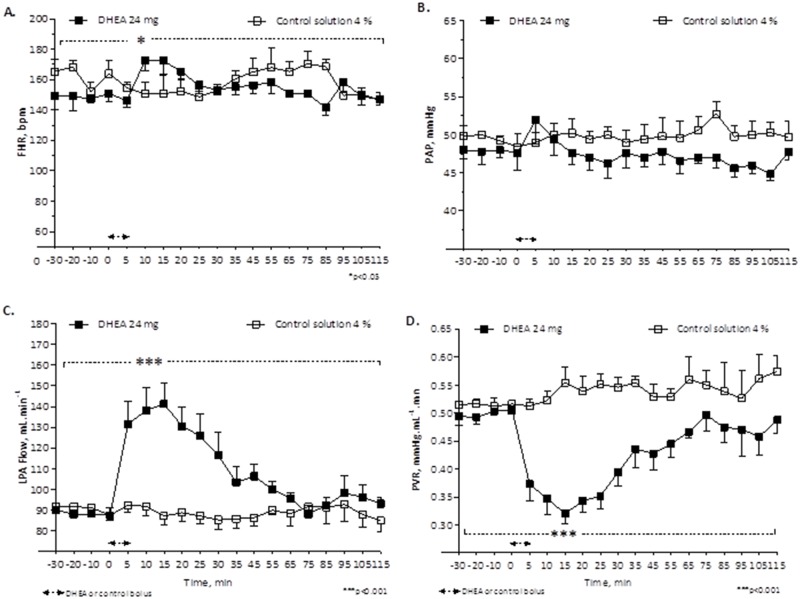
Change in fetal heart rate, FHR (A), pulmonary artery pressure, PAP (B), left pulmonary artery blood flow, LPA flow (C) and pulmonary vascular resistance, PVR (D) in response to bolus of 24 mg DHEA compared to bolus of control solution 4%.Values are means ±SEMs, n = 5, (DHEA 24 mg) and n = 4, (control 4%). *p<0.05 significant difference of FHR comparing baseline vs. 24 mg DHEA bolus ***p<0.001 comparing baseline vs. 24 mg- DHEA bolus (one-way ANOVA) and comparing 24 mg- DHEA bolus vs. control 4% (Two-way ANOVA).